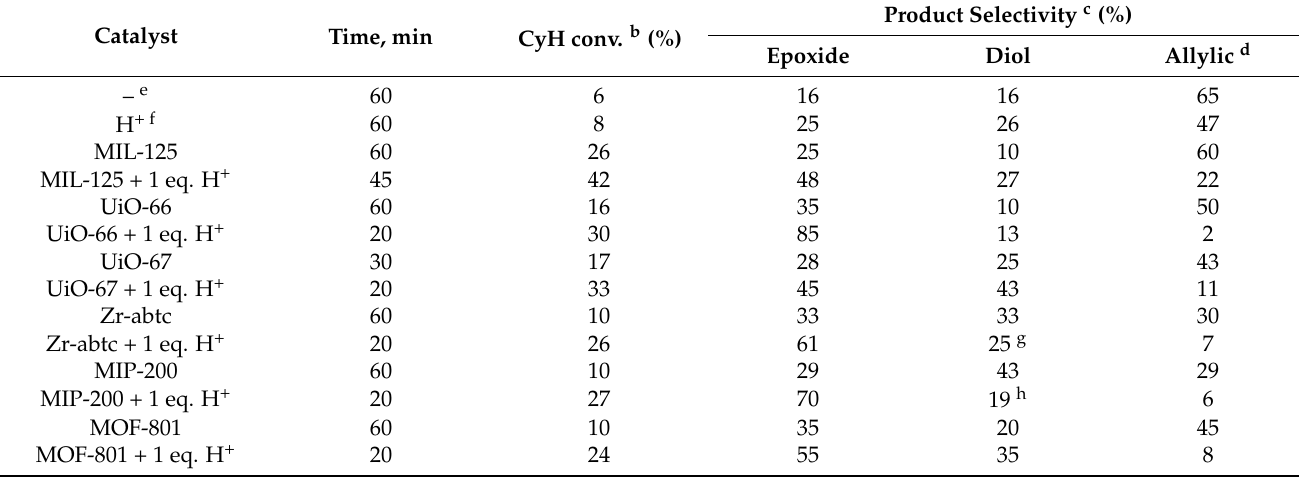
Table 4. Effect of protons on CyH oxidation with H 2 O 2 over Ti-MIL-125 and Zr-MOFs (adapted from references [92,116,117]) a . Catalyst Time, min CyH conv. b